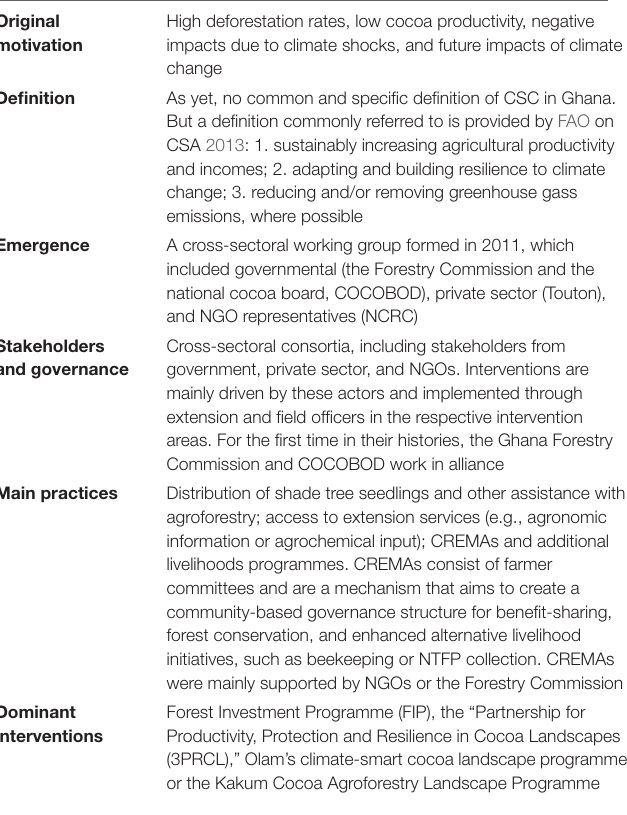
TABLE 2 | Overview of CSC in Ghana.